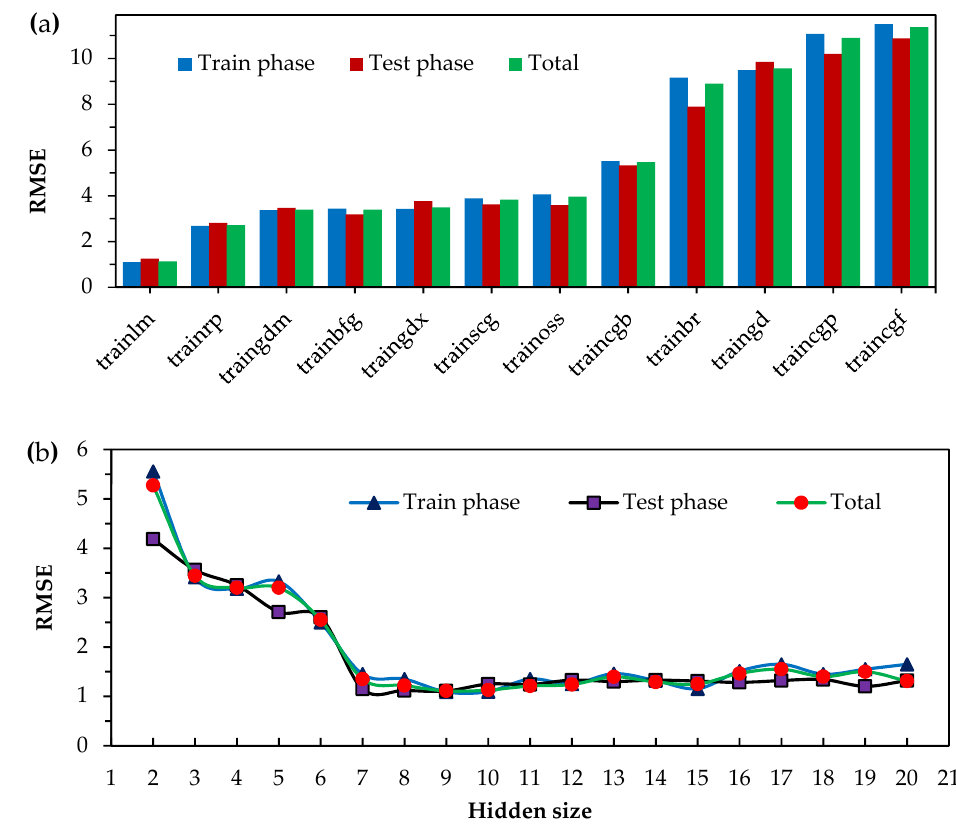
Figure 1. ( a ) Effect of training algorithm types, and ( b ) neuron numbers in the hidden layer on RMSE in the three stages of training, test and all data.